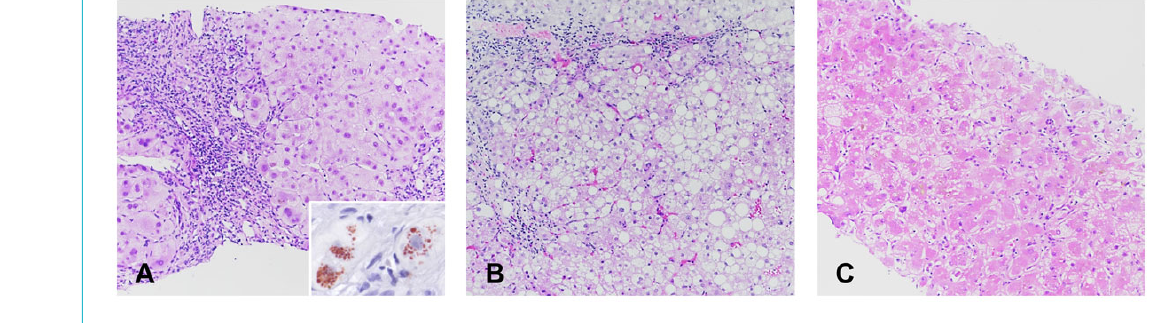
Fig. 1: Histological patterns observed in patients with Wilson’s disease. (A) Severe chronic hepatitis characterised by numerous inflam- matory cells in the portal tracts, interface hepatitis and advanced fibrosis (patient 10, haematoxylin-eosin, × 10). Copper granules can be iden- tified in the cytoplasm of periportal hepatocytes (insert, rhodanine stain, × 40). (B) Steatohepatitis with macrovesicular steatosis, ballooned he- patocytes and mild inflammation and fibrosis (patient 8, haematoxylin-eosin, × 10). (C) Multifocal necrosis (patient 9, hematoxylin-eosin, ×